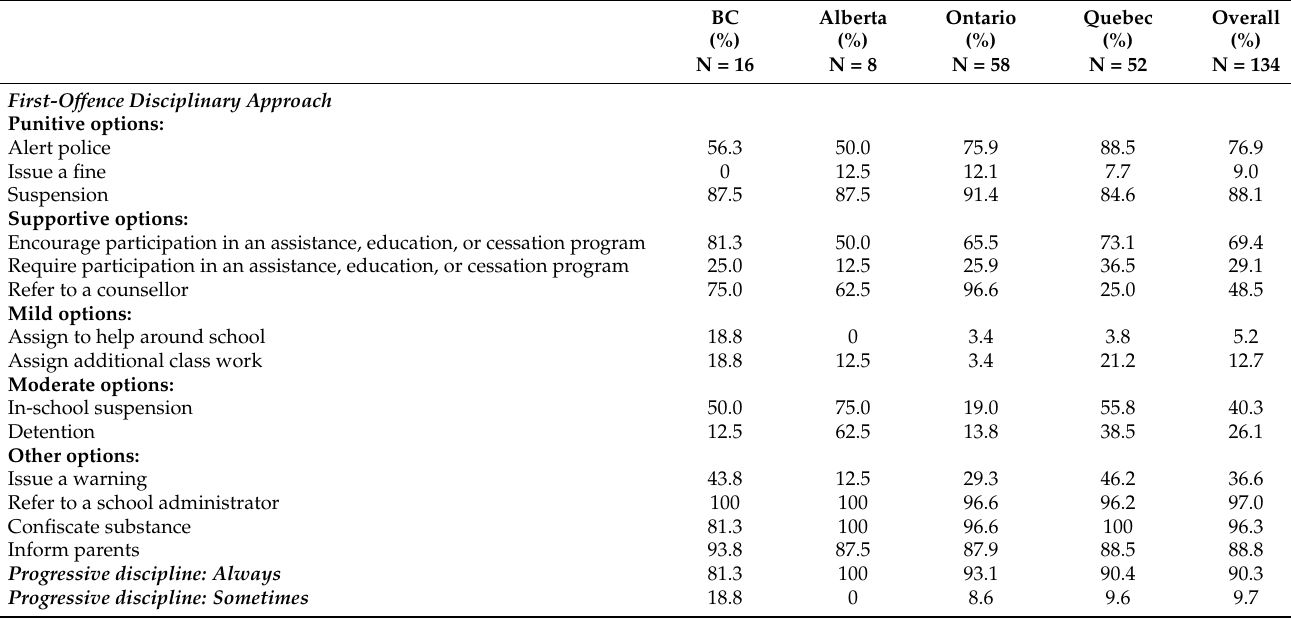
Table 1. Prevalence of disciplinary approach options selected by Canadian secondary schools (n = 134) for use in response to student violations of school cannabis policies by province in Year 7 (2018/19) of the COMPASS